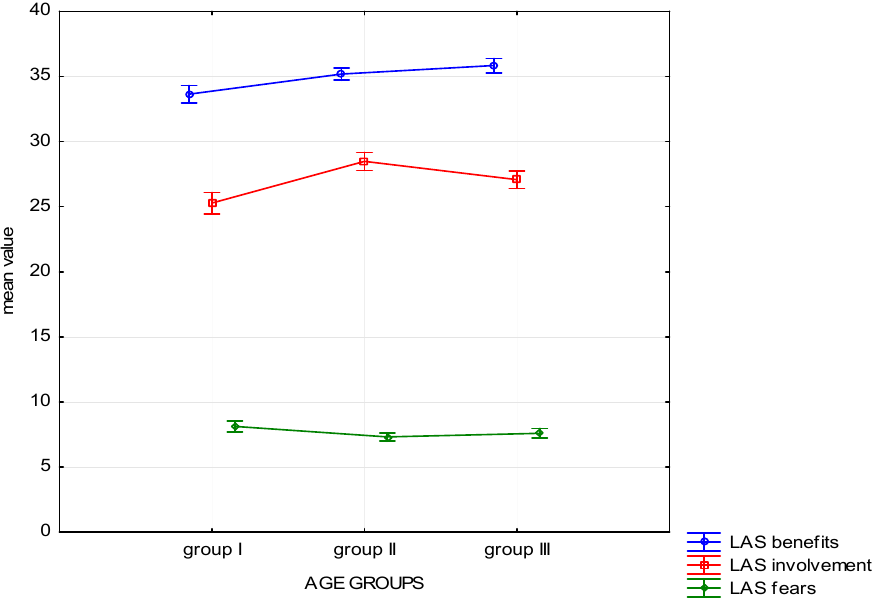
Figure 1. Attitude to the forest—mean chart for groups divided by age.